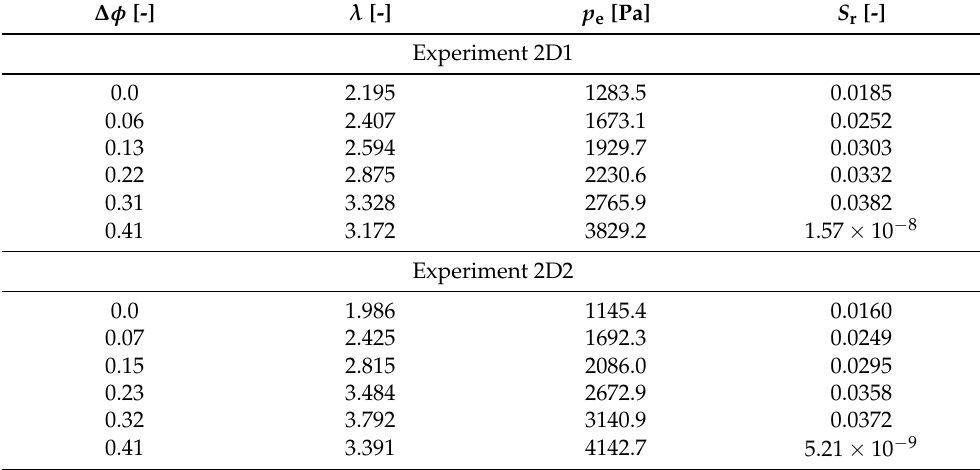
Table 1. Parameters of the Brooks–Corey capillary pressure–saturation relation (Equation (4)) for various porosity reductions ∆ φ due to EICP. ∆ φ [-] λ [-] p e [Pa] S r